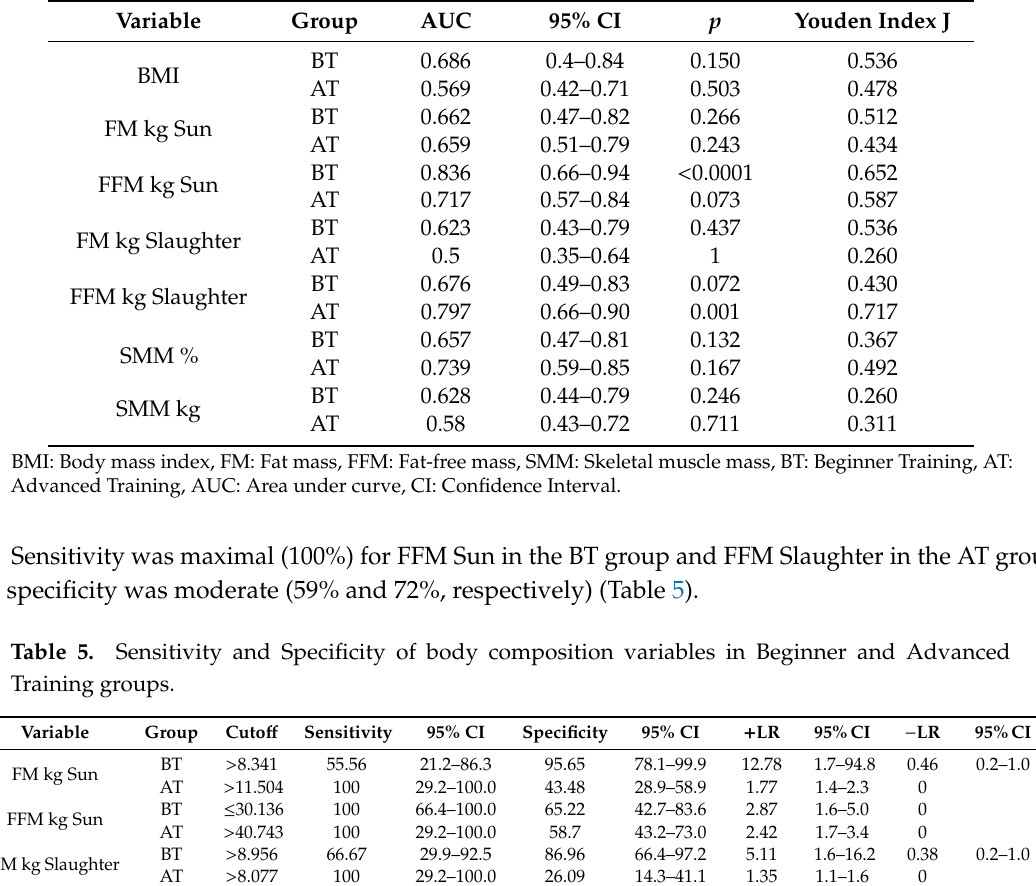
Table 4. Characteristics of receiver operating characteristics (ROC) curves of body composition variables in Beginner and Advanced groups.